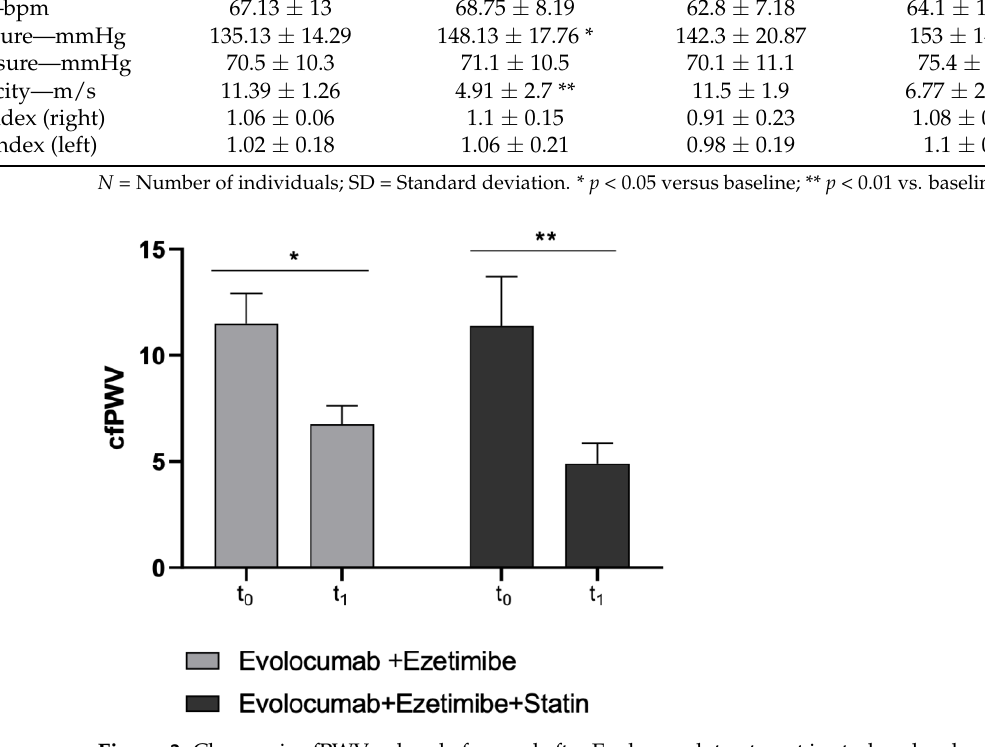
Figure 3. Changes in cfPWV values before and after Evolocumab treatment in study sub-cohorts (Ezetimibe group and Ezetimibe+ Statin group). * p <0.05 and ** p <0.01 significantly different vs. t 0 ibe group and Ezetimibe+ Statin group). * p < 0.05 and ** p < 0.01 significantly different vs. t 0 values.